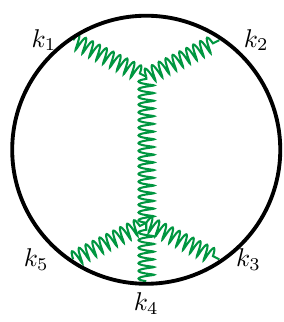
Figure 5 . Five point type-b vector